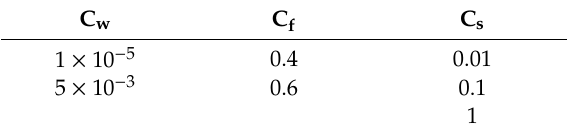
Table 2. Coefficient values tested during the calibration. Table 2. Coe ffi cient values tested during the calibration.